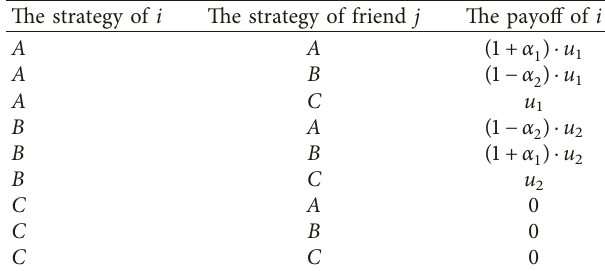
Table 2: The payoff of an individual, depending on their strategy and their friend’s